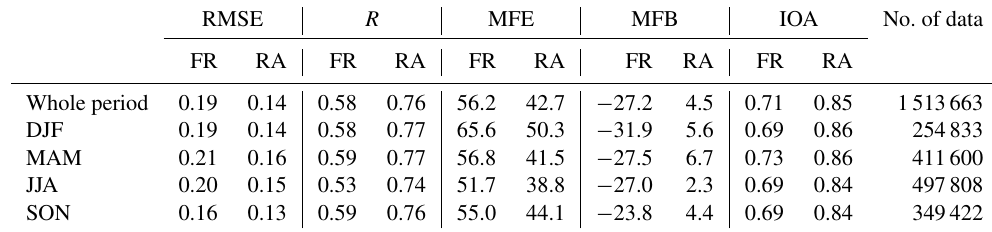
Table 3. Statistical measures of the 1h binned AERONET AODs versus FR and RA AODs. RMSE R MFE MFB